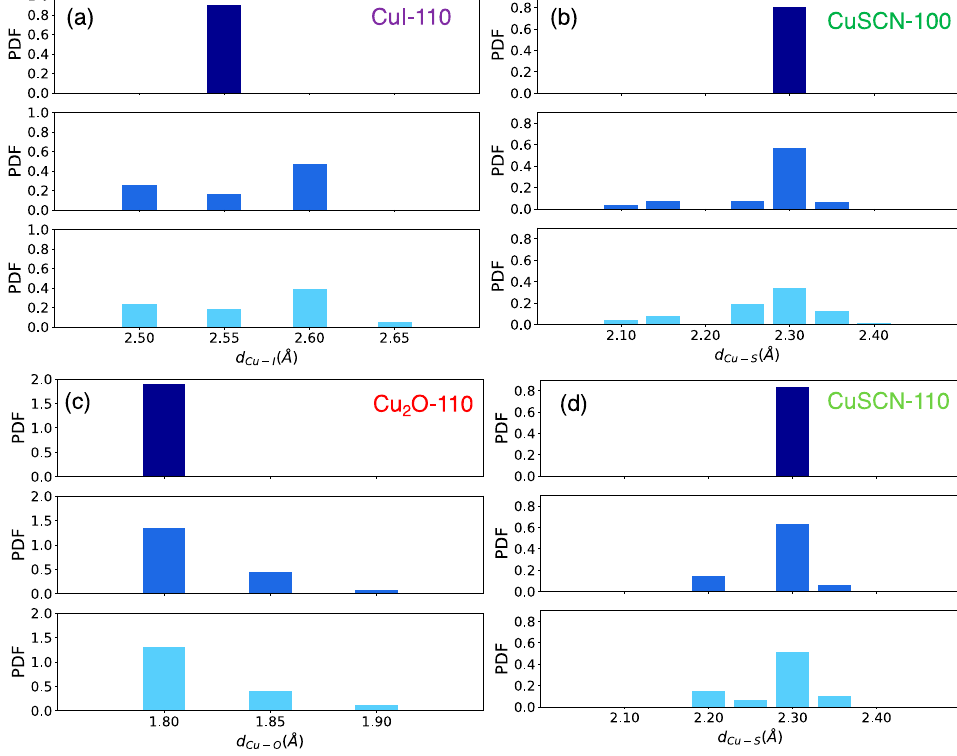
Figure 5. Pair distribution functions of: ( a ) Cu-I bond distances for the CuI slab, ( b , d ) for the Cu-S bond distances of the (100) and the (110) CuSCN slabs, respectively, and ( c ) Cu-O bond distances for the Cu 2 O slab. Dark blue color is used for structures before relaxation, while medium and light blue refer to the pristine and the defective optimized structures, respectively.